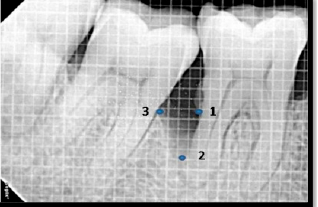
Figure 1. Pictorial representation of points considered during intrabony defect depth (IBD) mea- surement. 1 = Alvelolar bone crest (AC); 2 = Intrabony defect base (BD); 3 = Bone crest at defect width(BC).